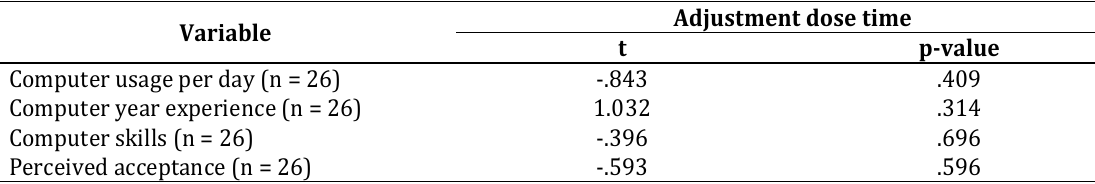
Table IV. Correlation analysis between computer literacy and dose adjustment time Variable